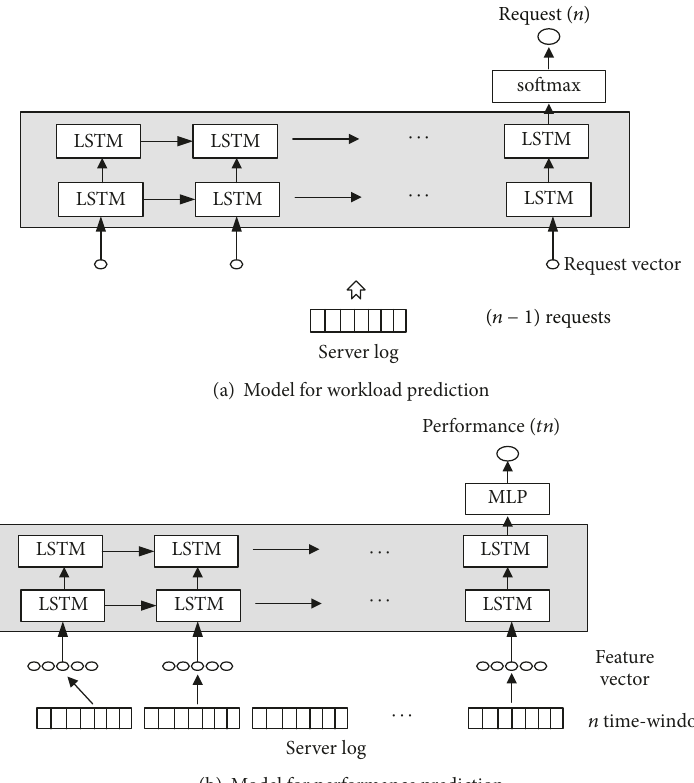
Figure 2: The network structure for two models: (a) model for workload prediction and (b) model for performance prediction. Model (a) takes request vectors as the input and output of the network, using the latest 𝑛 − 1 requests to predict the 𝑛 th request. The input of model (b) is the latest 𝑛 feature vectors extracted from the log of every time-window, and its output is the value of certain kind of performance in 𝑛